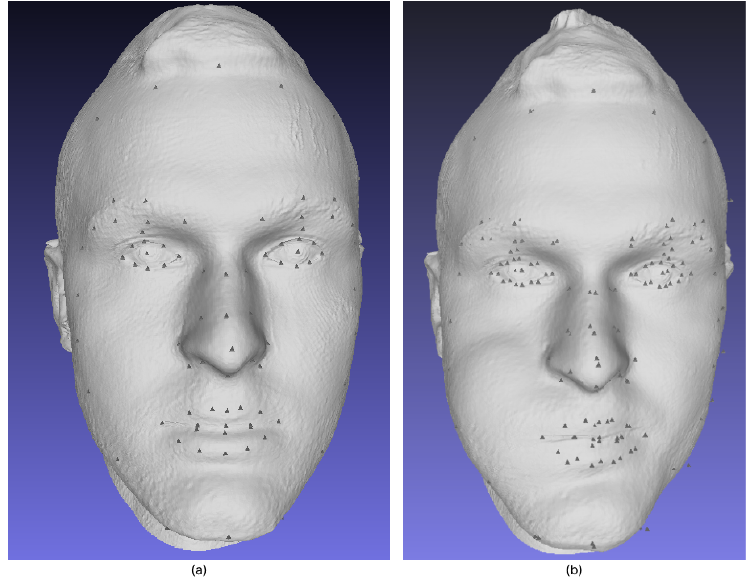
Figure 1. Three dimensional (3D) face mesh with facial landmarks ( a ) Face mesh before operation ( b ) Face mesh after